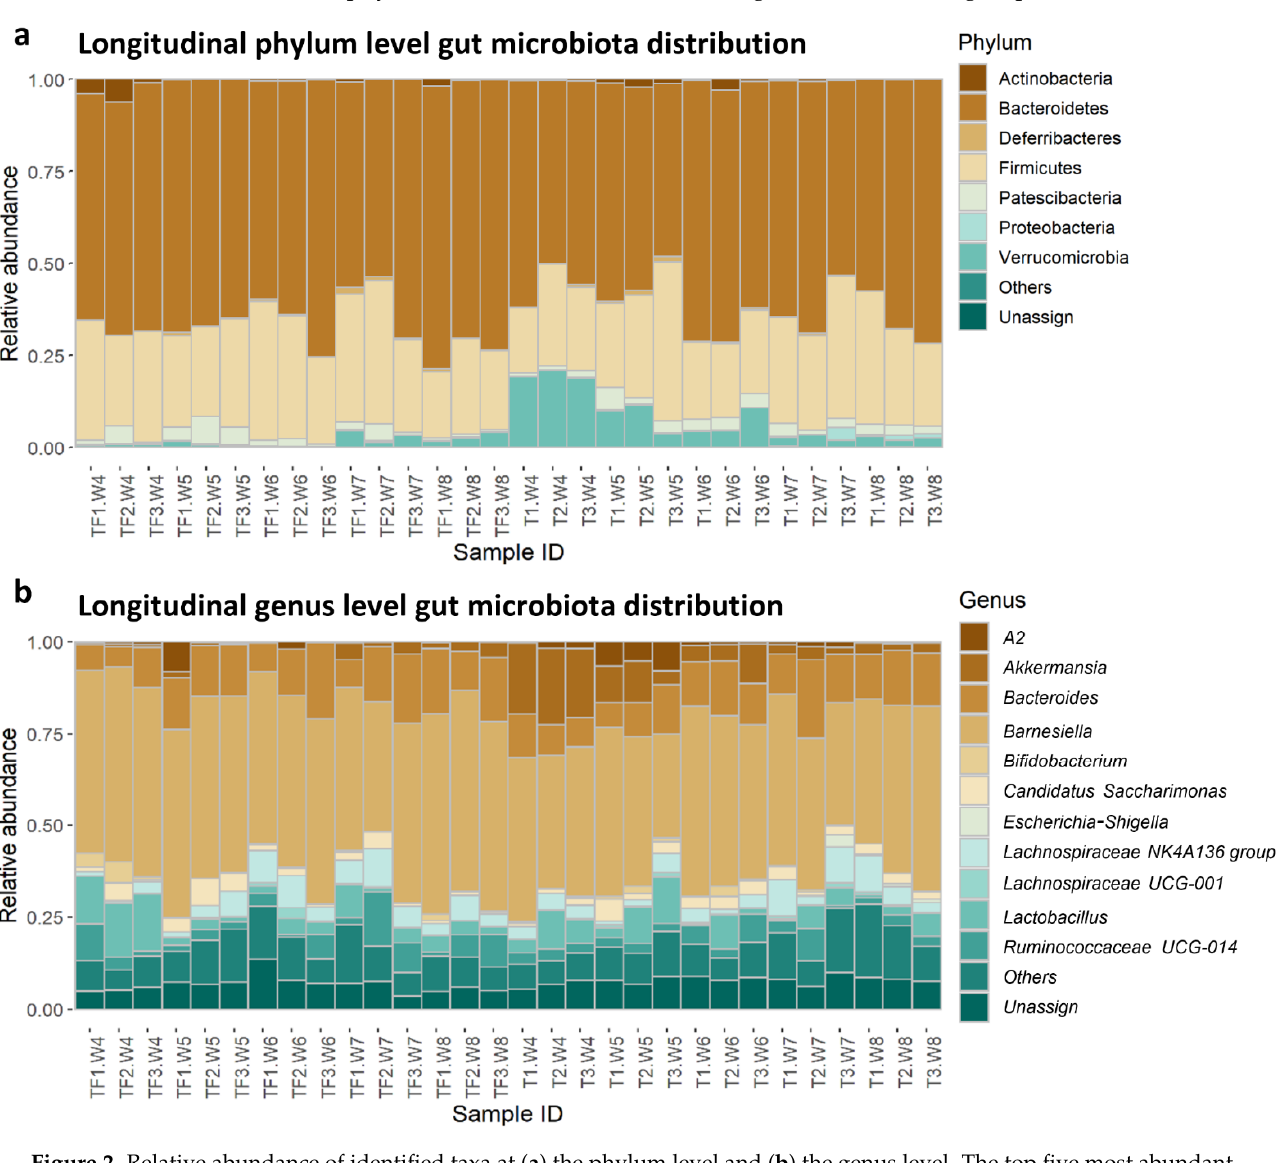
Figure 1. Tumor-specific bioluminescent images in representative mice. Groups of NOD-SCID mice (N = 5, age of eight weeks) were inoculated with 3 × 10 5 cells of metastatic human prostate cancer 22Rv1-M4 cells vs. mock control (PBS). Based on the housekeeping expression of the luciferase 2 (Luc2) reporter gene in the tumor cells, in vivo bioluminescent imaging of tumors was captured and quantified using an IVIS Lumina XRMS System weekly as marked.